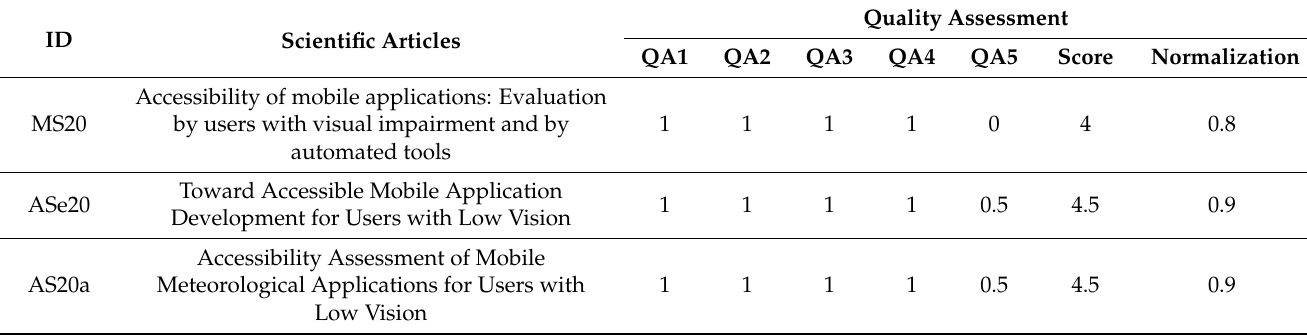
Table 3. Selected scientific articles and quality assessment